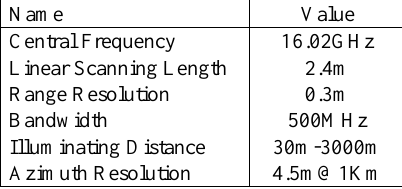
Table 1. Information of the SDMR-1 GB-SAR system